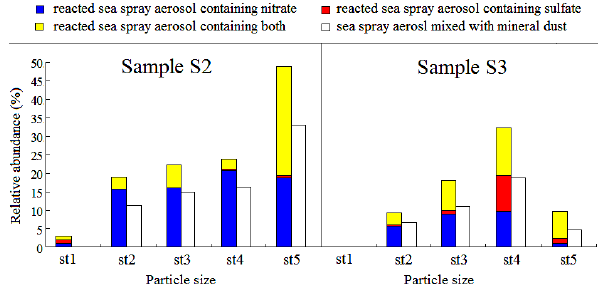
Fig. 10. Relative abundance percentages of various types of reacted SSAs (and mixture) in samples S2 and S3.